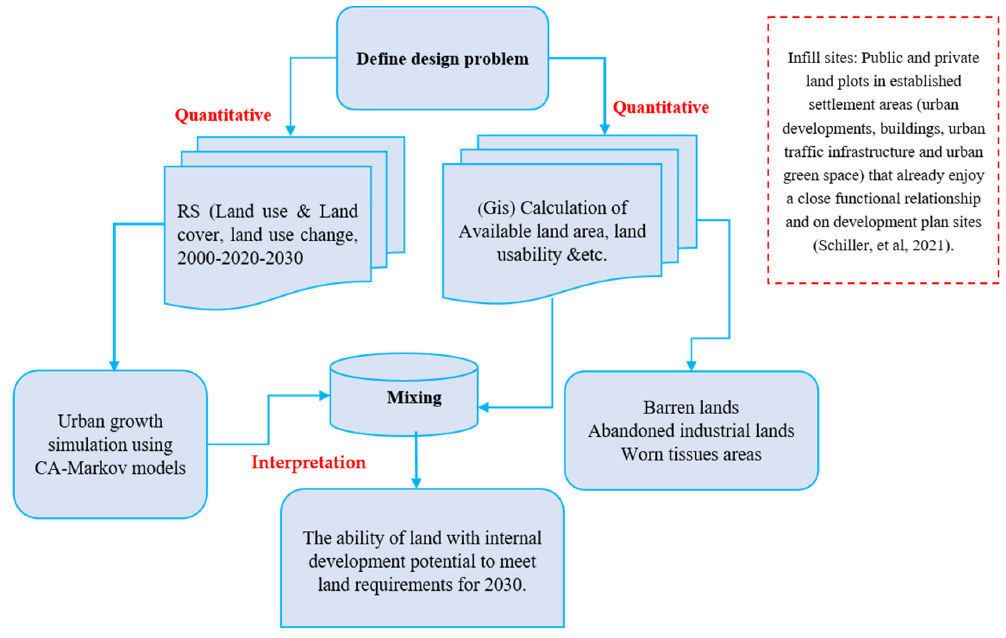
Figure 4. Methodology flowchart of this